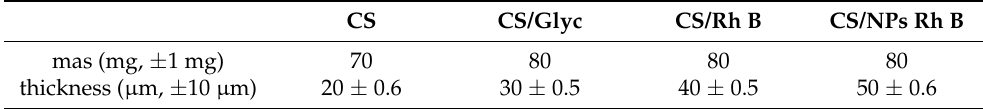
Table 1. Masses and thicknesses ± standard deviation of chitosan films (CS) of different components (Glyc, Rh B, and NPs RH B).